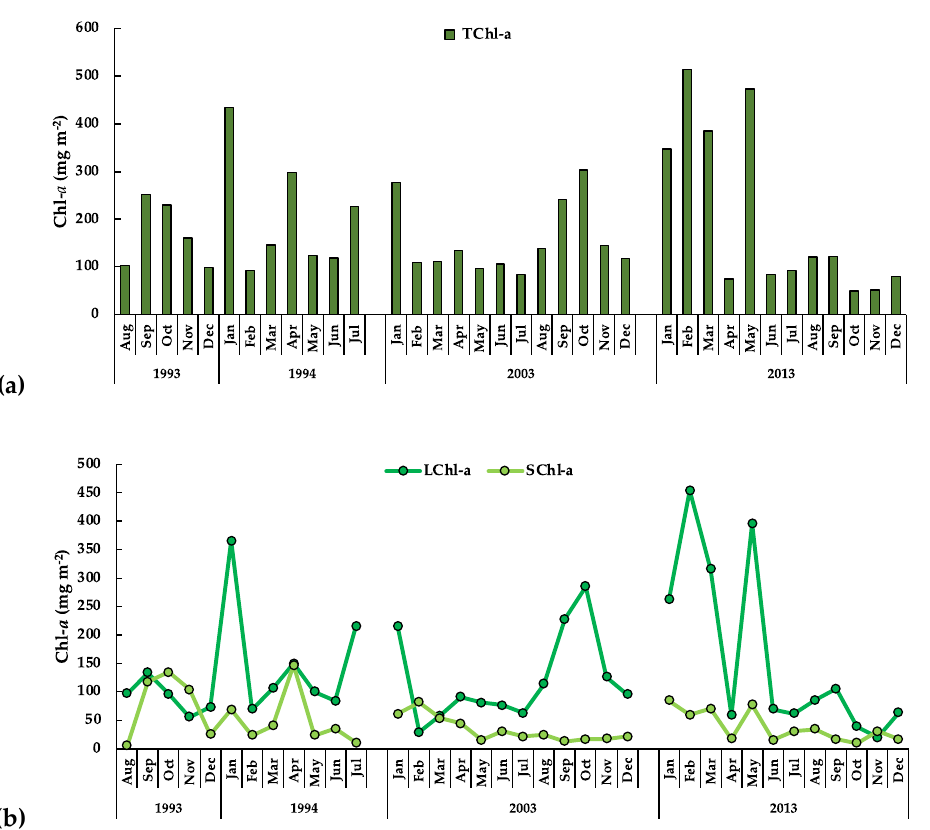
Figure 8. Temporal dynamics of the total water-column ( a ) integrated chlorophyll a concentration (Chl- a ) and ( b ) size-fractionated (large Chl- a ≥ 2 µ m and small Chl- a < 2 µ m) in Lake Alchichica. (Please note, the 1993–1994 cycle begins in August, while 2003 and 2013 in January).